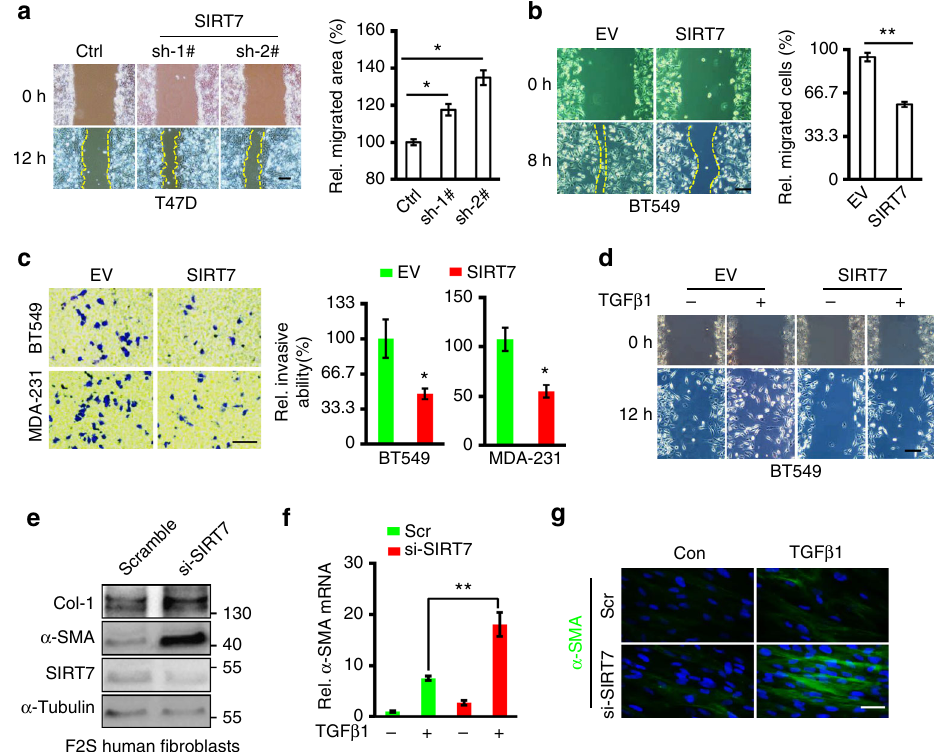
Fig. 4 SIRT7 inhibits breast cancer motility. a , b Wound healing assay of SIRT7 KD T47D cells a and SIRT7-overexpressing BT549 cells b . Scale bar , 100 µ m. c Representative images of Transwell invasion assay for SIRT7-overexpressing breast cancer BT549 and MDA-MB-231 cells. Cell number was counted in six randomly captured pictures. Invasive ability was normalized to control. Scale bar , 100 µ m. d Wound healing assay in BT549 cells expressing ectopic SIRT7 in the presence or absence of TGF- β 1 (5 ng/ml). Scale bar , 100 µ m. e Immunoblots showing Col1a1 and α -SMA in F2S human fi broblast cells treated with Scramble or si-SIRT7. f , g Quantitative RT-PCR and immuno fl uorescence staining of α -SMA in the Scramble (Scr) or si-SIRT7-treated F2S cells in the presence or absence of TGF- β 1 (5 ng/ml). Scale bar , 50 µ m. Data are shown as mean ± S.E.M. * P < 0.05, ** P < 0.01. P -values are calculated by Student ’ s t